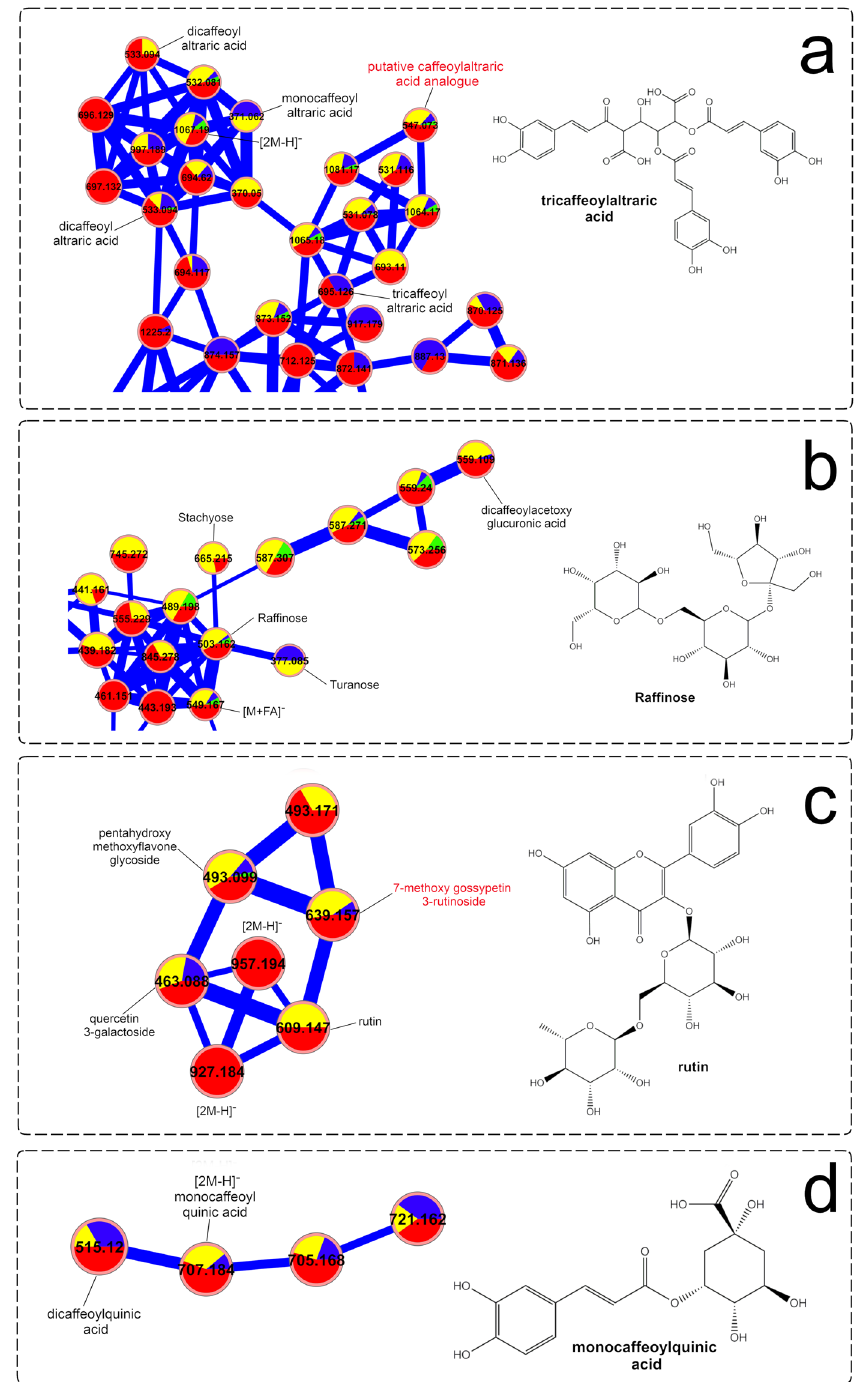
Figure 6. Molecular networks of Smallanthus sonchifolius ’ leaf extracts (analyzed by UHPLC-HRMS/MS in negative mode) showing specific clusters annotated as ( a ) caffeoylaltraric acids and derivatives, ( b ) free glycosides, ( c ) glycosylated flavonoids and ( d ) chlorogenic acids. The node size represents the mean retention time value of each parent ion with larger nodes representing higher retention times. Node color represents the metabolic developmental stage of the collected samples as follows: green: 0.5 to 1-month-old plants; blue: 1.5-month-old plants; yellow: 2 to 4-month-old plants and red: 4.5 to 6-month-old plants. Edge width depicts the cosine similarity between different MS/MS spectra (0.65 < r > 0.95) with thicker edges representing higher cosine